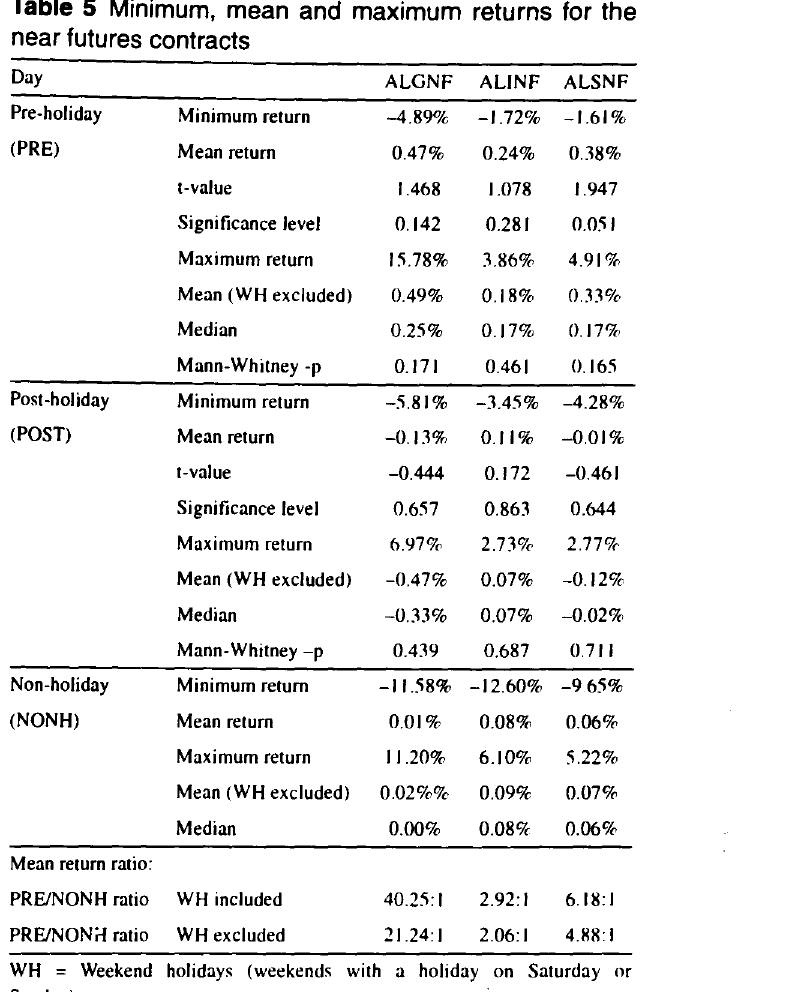
Table 5 Minimum, mean and maximum returns for the near futures